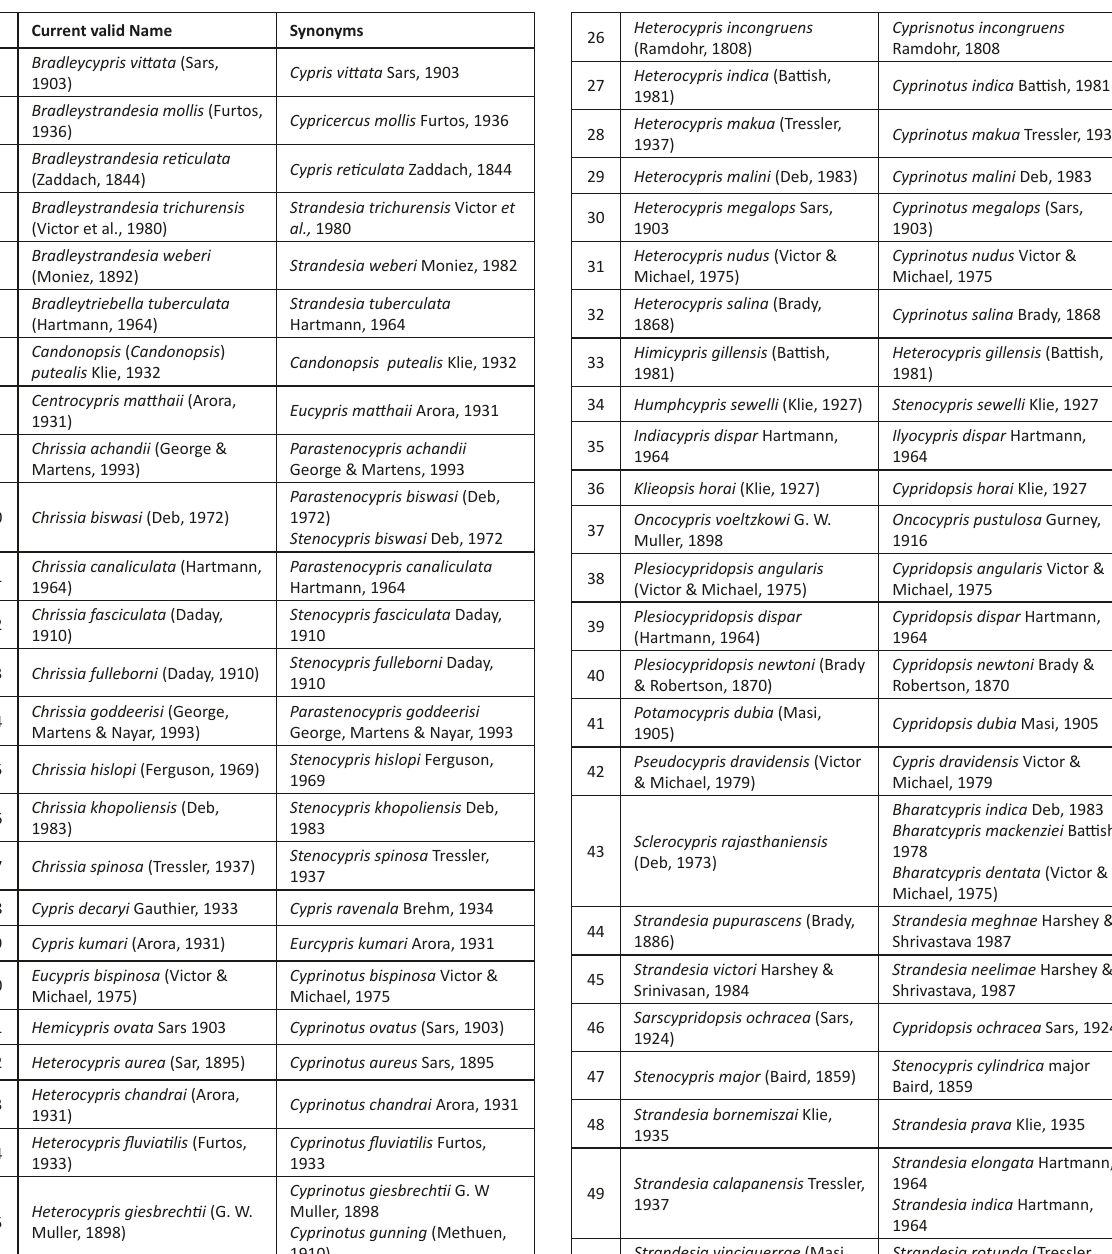
Table 3. List of Indian freshwater Ostracoda current valid names and